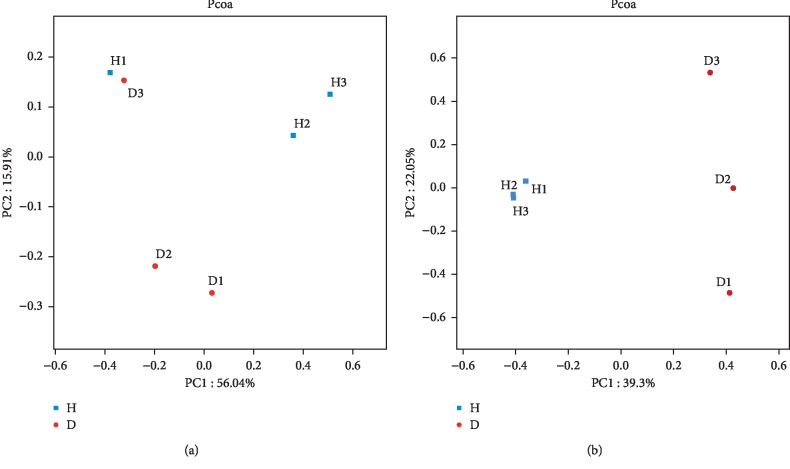
Principal coordinate analyses (PCoA) for bacteria (a) and fungi (b) in the rhizosphere soil of healthy and rusty root-affected Panax ginseng. All values are presented as means ± SE (n = 3). H: healthy plants; D: diseased plants.